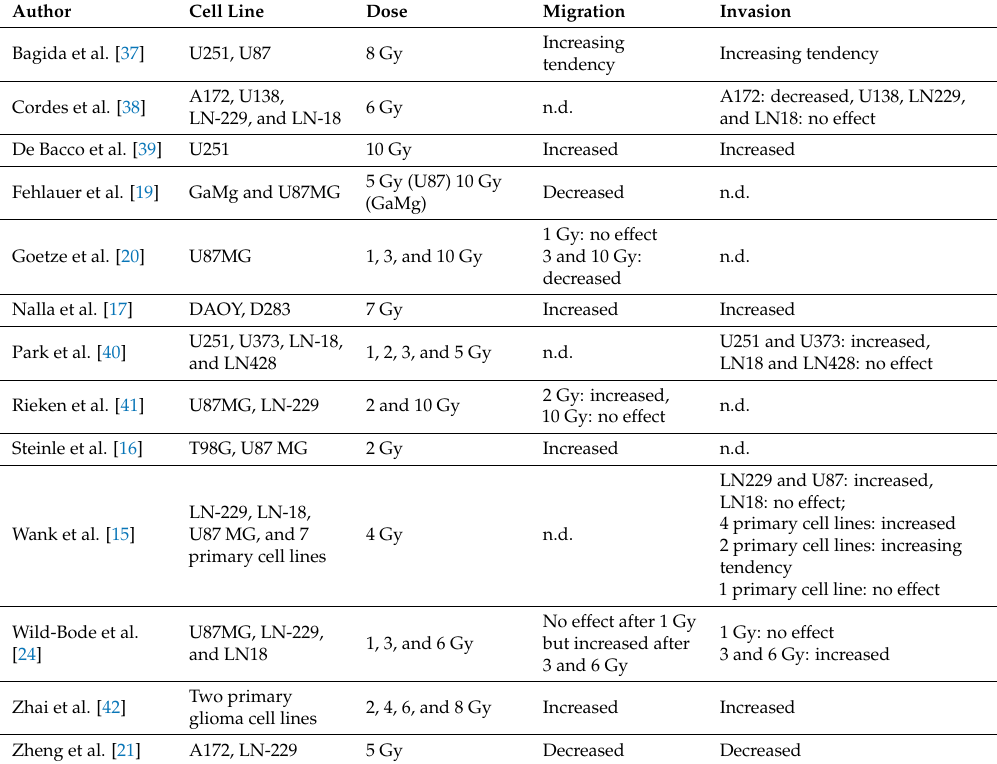
Table 2. In vitro studies investigating migration and invasion after low LET irradiation. Not determined values are marked with